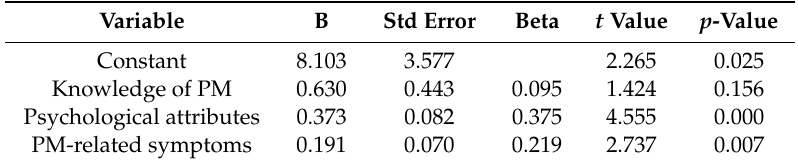
Table 12. Multiple regression analysis of the response behaviors to particulate matter. 344